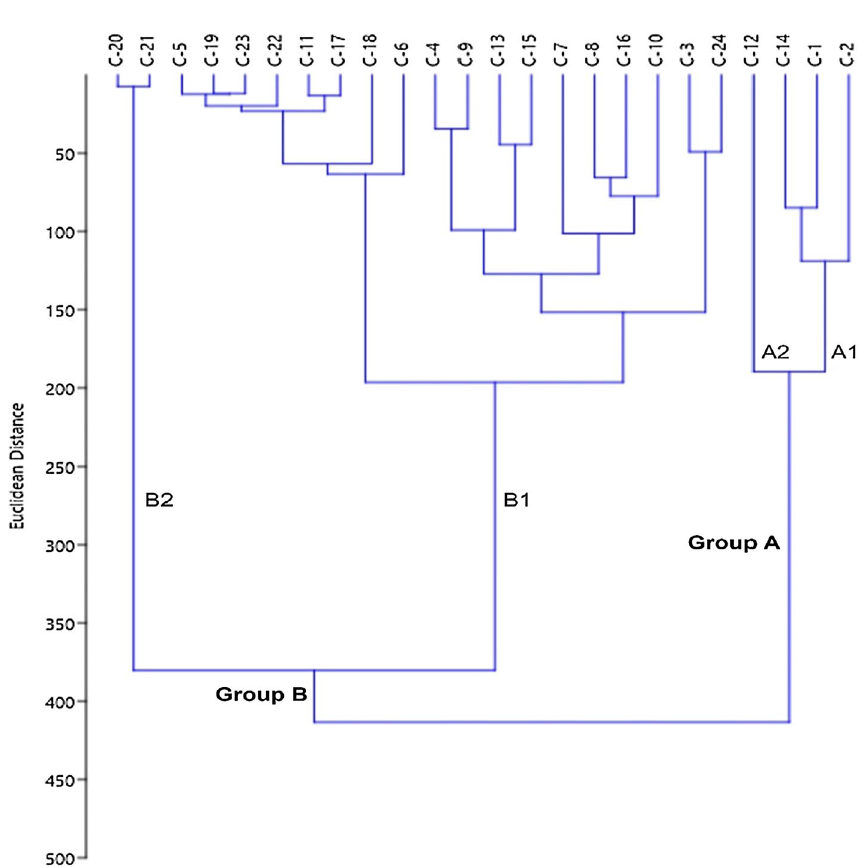
Fig. 4 Dendrogram derived from unweighted pair group ordination using the Euclidean